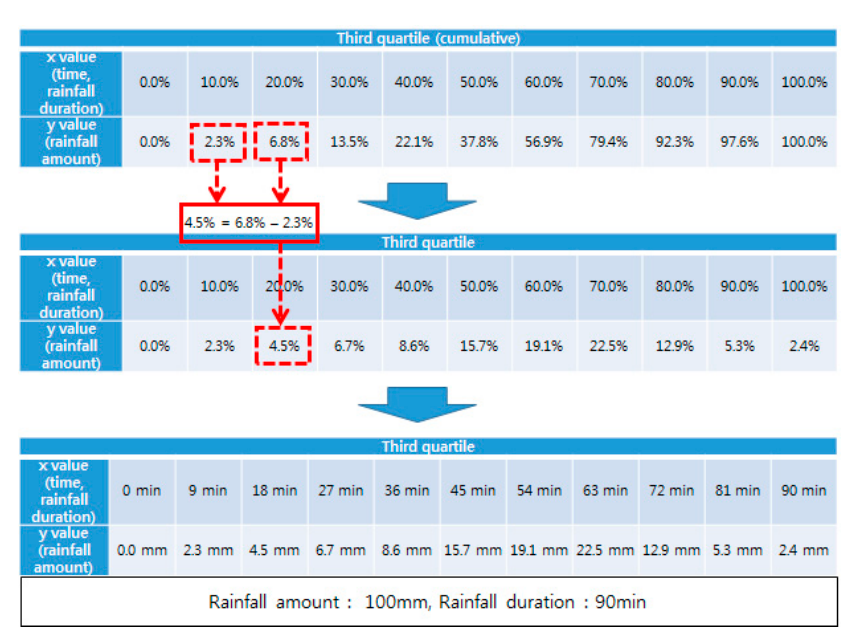
Figure 1. Process for obtaining rainfall data using the Huff distribution.